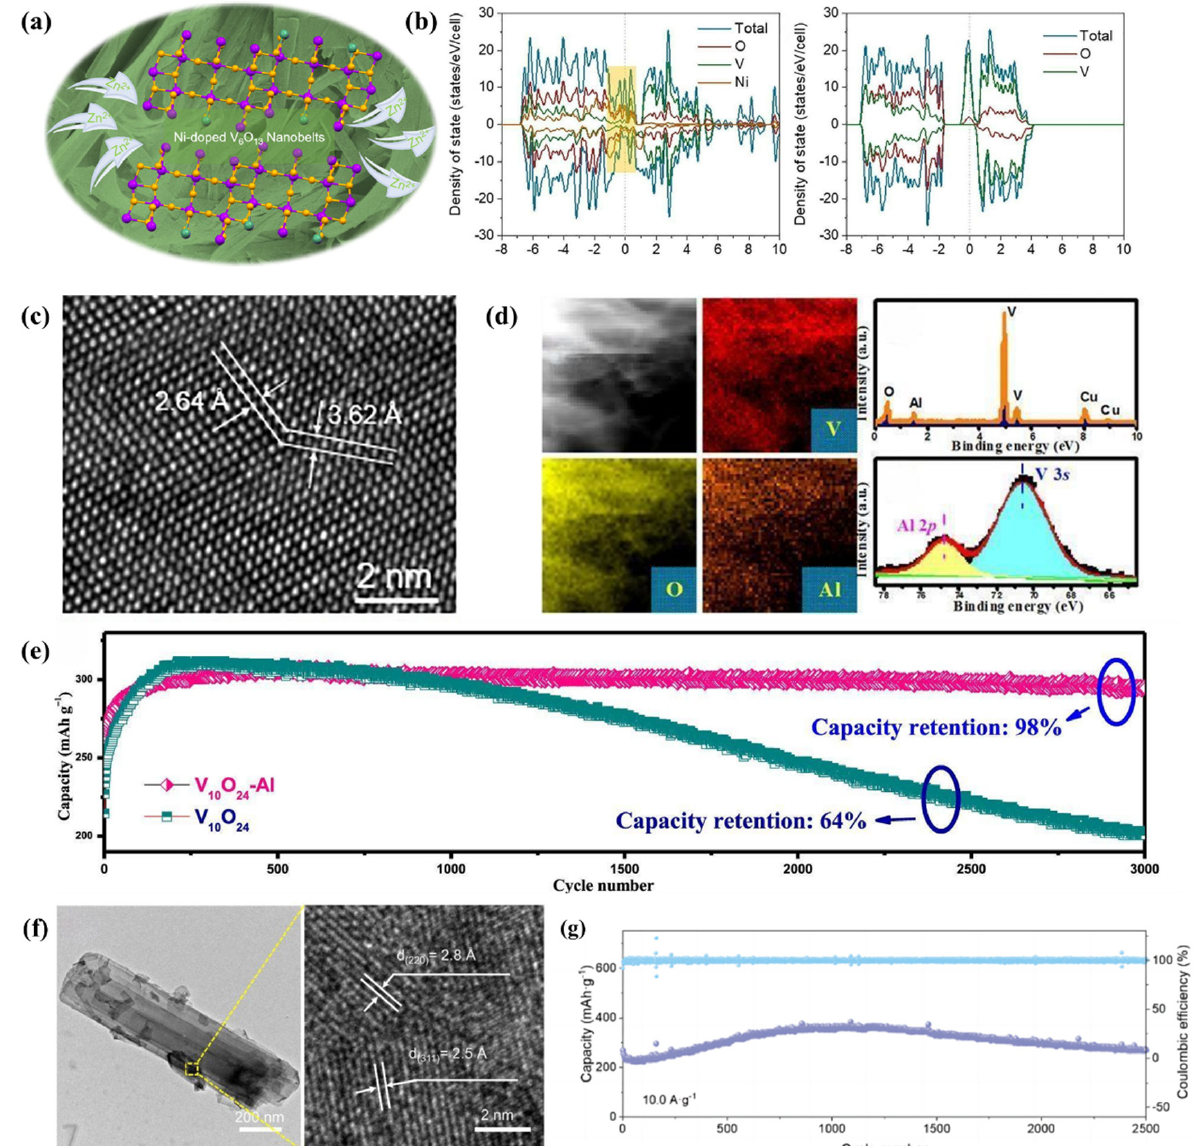
Figure 3. ( a ) Zn 2+ storage diagram of Ni x V 6 − x O 13 cathode material (Ref. [39]). ( b ) Density of states (DOSs) of Ni x V 6 − x O 13 and V 6 O 13 are calculated by density function theory (DFT) (Ref. [39]). ( c ) High − resolution transmission electronic microscopy (HRTEM) images of Ni x V 6 − x O 13 (Ref. [39]). ( d ) Element mapping images, energy dispersive X − ray (EDX) spectra and X − ray photoelectron spec- troscopy (XPS) spectra of Al − doped V 10 O 24 (Ref. [40]). ( e ) Long − term cycling performance of V 10 O 24 and V 10 O 24 − Al (Ref. [40]). ( f ) Scanning electronic microscopy (SEM), transmission electronic mi- croscopy (TEM), and HRTEM images of VO 2 @NC (Ref. [49]). ( g ) Long cycle performance of VO 2 @NC (Ref. [49]).